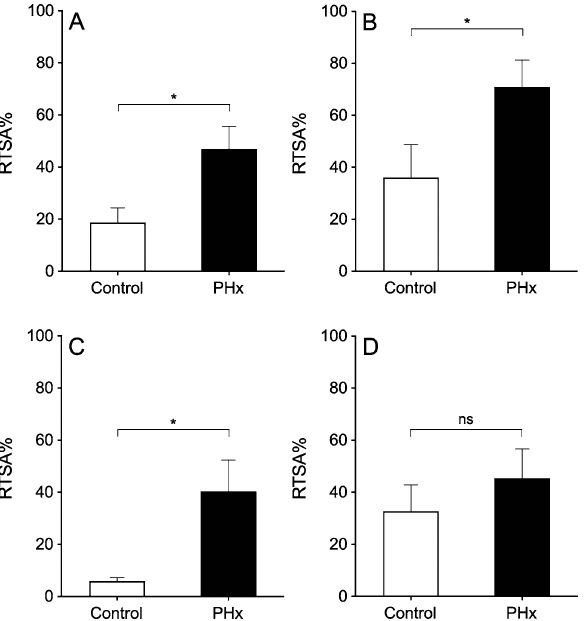
Figure 4. Relative tumour surface area percentage (RTSA%). Bar graphs of total liver mass RTSA% ( A ), caudate lobe RTSA% ( B ), paramedian lobe RTSA% ( C ) and right lateral lobe RTSA% ( D ) of both control (non-hepatectomized animal; white) and PHx (hepatectomized animal, black) groups. Asterisk show statistical differences ( p < 0.05). Figure and analysis were performed using GraphPad Prism version 6.04 for Windows, GraphPad Software, San Diego, California USA, www.graph pad.com.